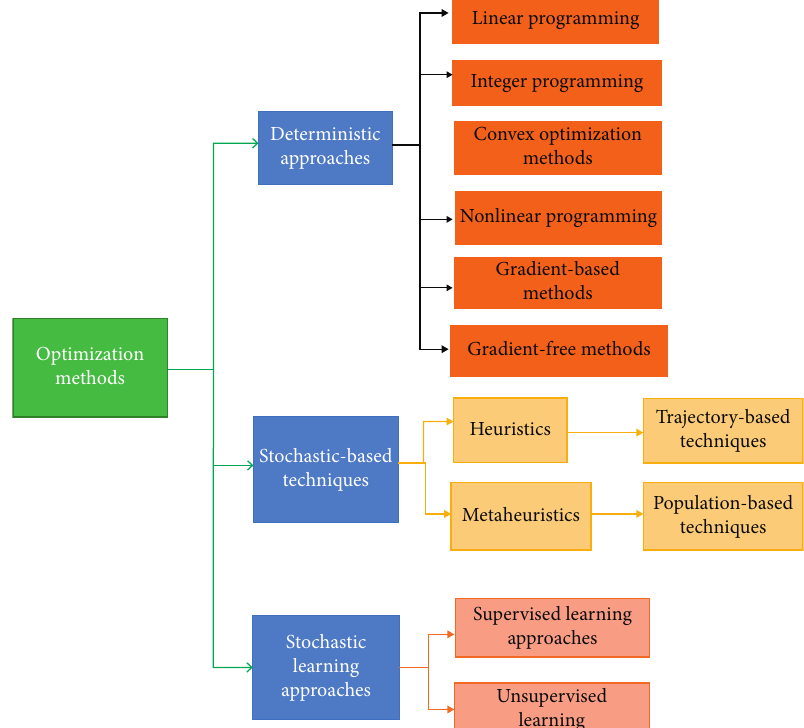
Figure 1: Classification of optimization